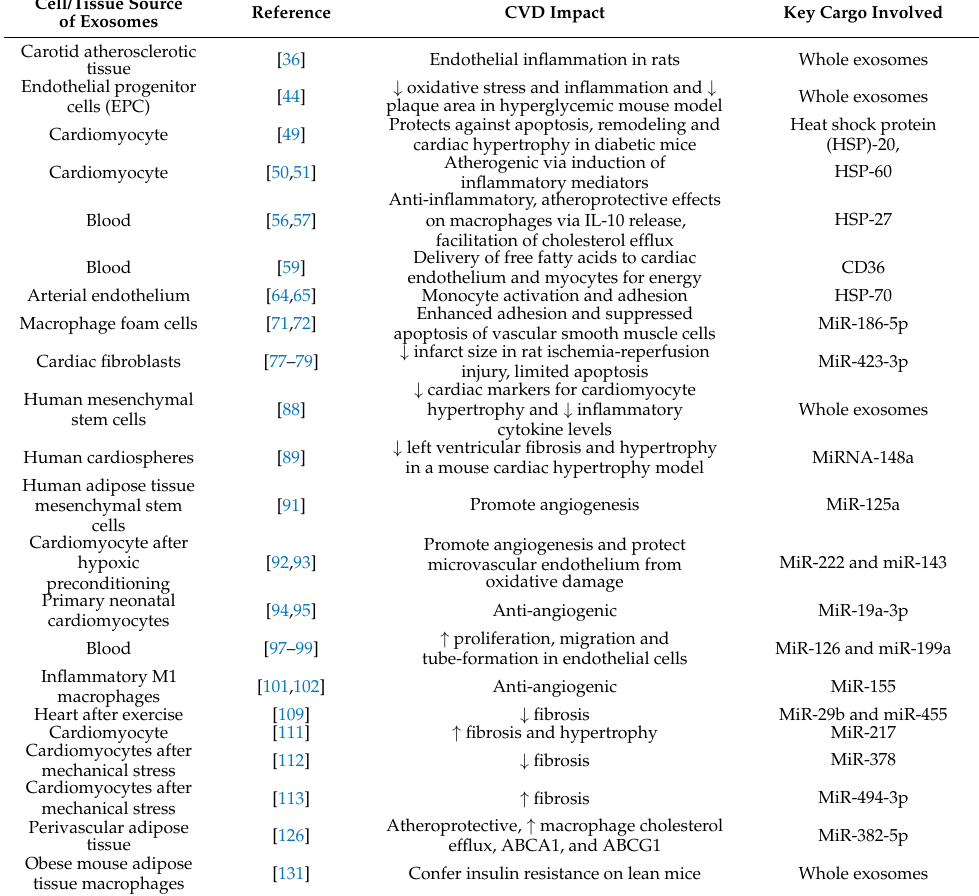
Table 1. Summary of cardiovascular impact of exosome cargo from specific cell and tissue